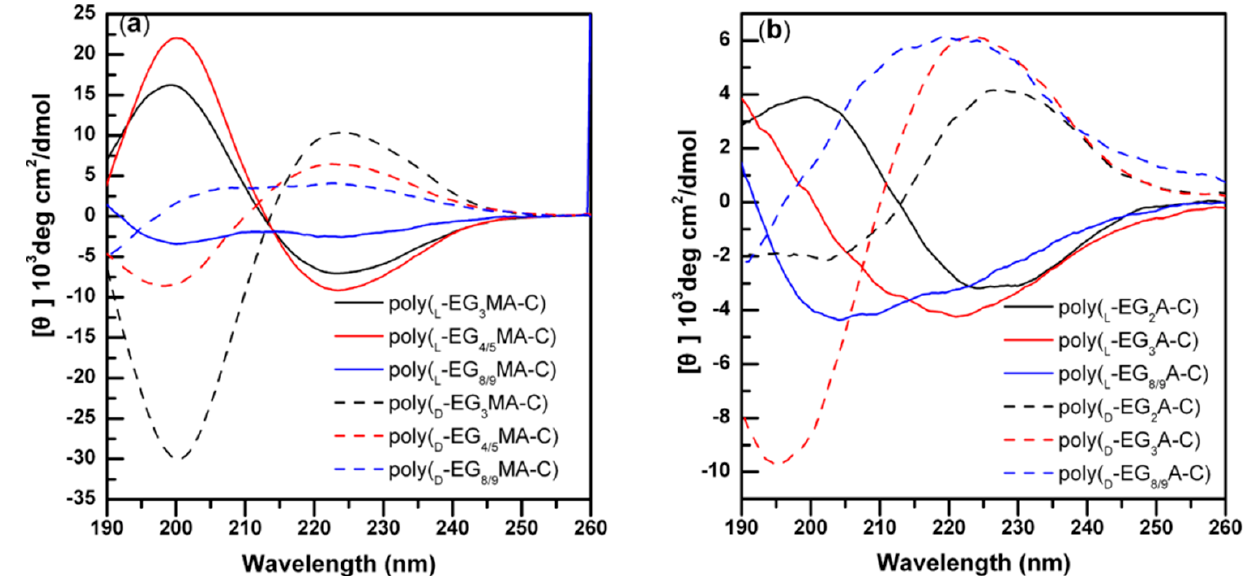
Figure 8. CD spectra of different OEGylated polycysteine homopolypeptides: ( a ) poly- L -EG x MA-C (solid line) and poly- D -EG x MA-C (dashed line); ( b ) poly- L -EG x A-C (solid line) and poly- D -EG x A-C (dashed line). Reproduced with permission [35]. Copyright 2013, American Chemical Society.